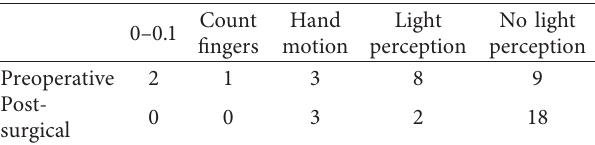
Table 4: Comparison of visual acuity before and after cyclocryotherapy.